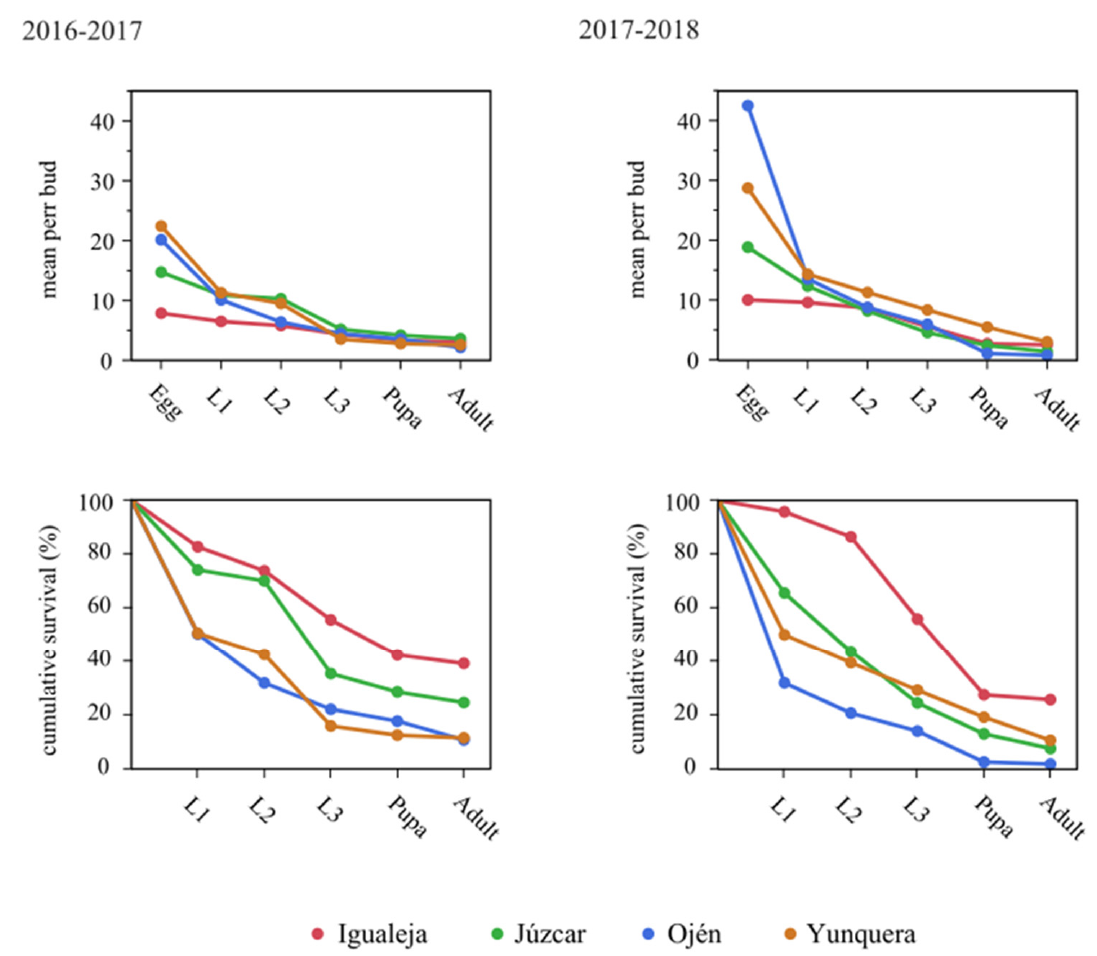
Figure 3. Pre-flight CGW relative abundance and survival in the sampled localities of Málaga. Above, mean number of each development stage of CGW per chestnut buds–galls in each locality at each vegetative period. Below, average survival probability per development stage in each locality at each vegetative period. See locality × year clustered heatmap in Figure S1.